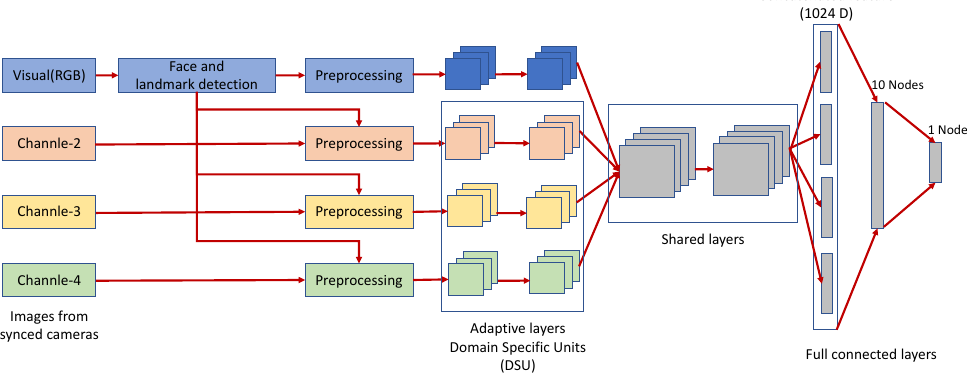
Figure 3. Architecture of Multi-Channel Convolutional Neural Network (MCNN)